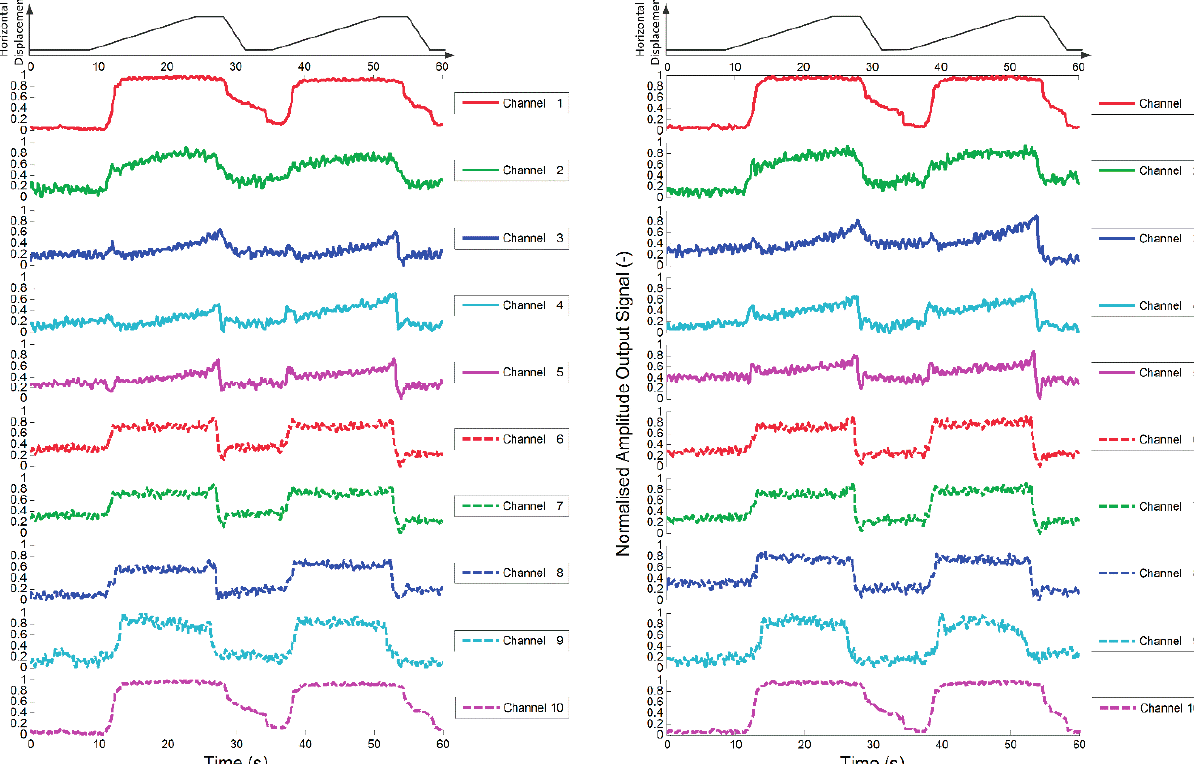
Figure 11. Plot of dynamic variation of peak value of short time Fourier analysis of sensor outputs during sliding test for two test sensors ( i.e. , alginate with fibroblasts). The first rows of each plot show the horizontal displacement of the stimulus, which was a cylinder with 2.5 mm